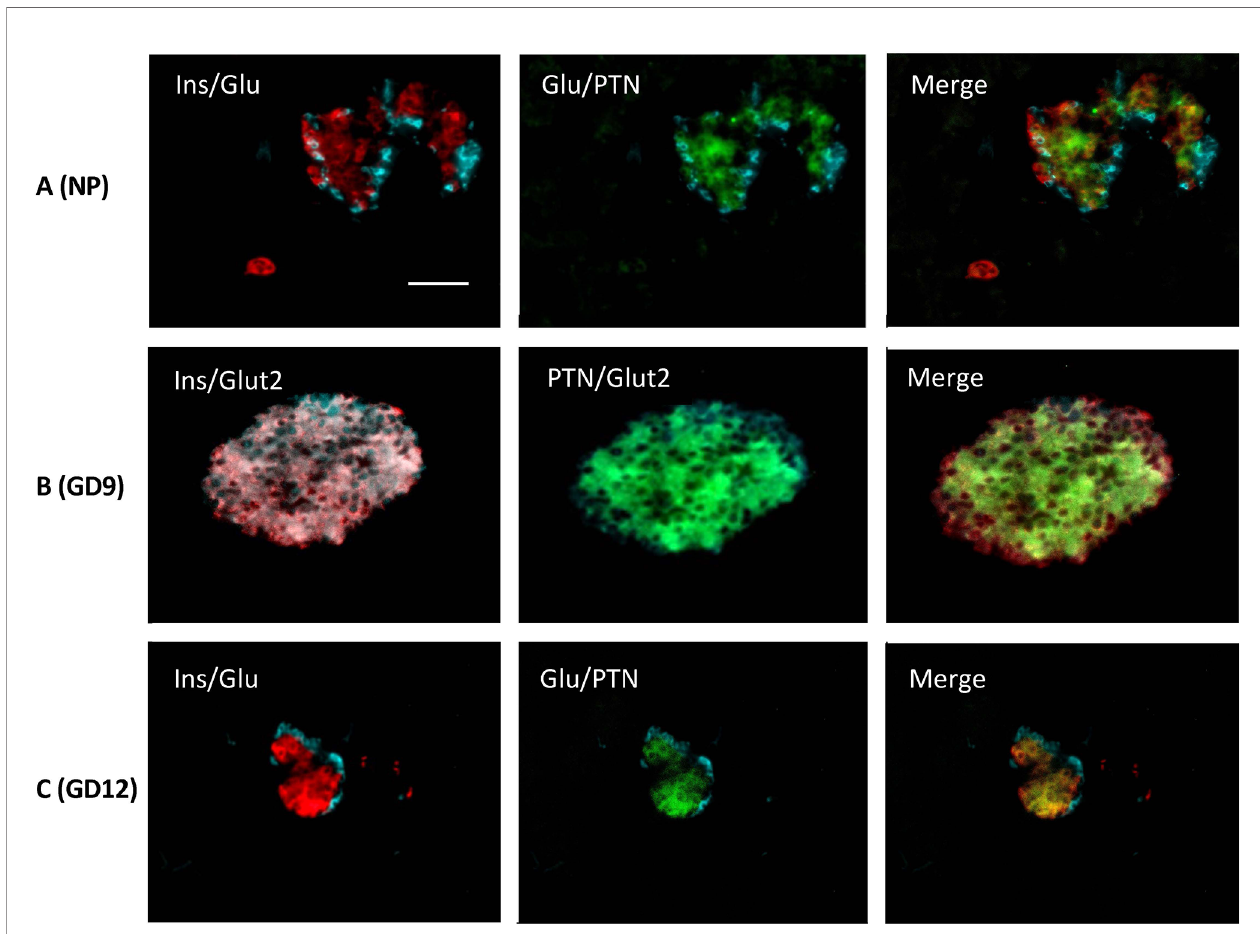
FIGURE 3 | Representative images showing immunohistochemical staining in adult mouse pancreas from non-pregnant animals ( A , NP), and during pregnancy at GD 9 (B) and GD 12 (C) . In (A, C) co-localization is shown left for insulin (red) and glucagon (cyan), and middle for glucagon (cyan) and PTN (green). In (B) co- localization is shown left for insulin (red) and Glut2 (cyan), and centre for PTN (green) and Glut2 (cyan). Merged images are shown right. Bar represents 100 m